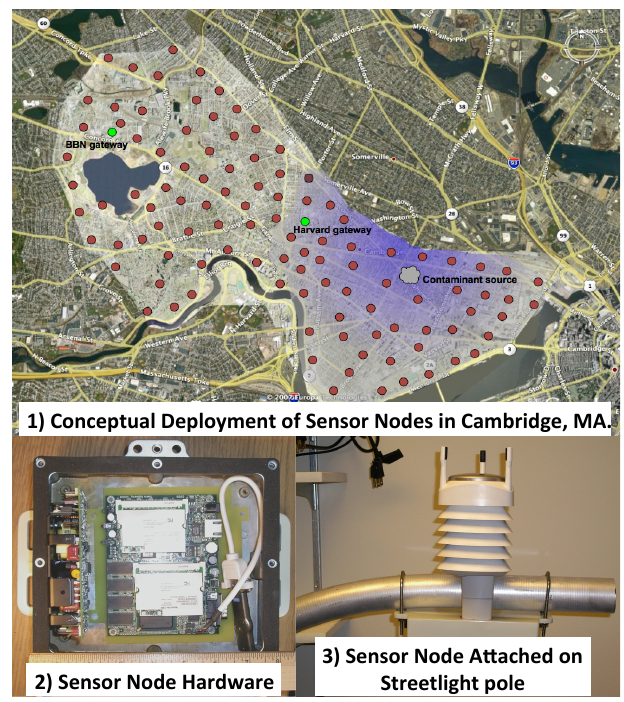
Figure 8. Example of the SSN system architecture and prototype. Red dots are the sensor nodes. Green dots are the gateways that forwarding the acquired data to the Contaminant Source. Figures are adapted from